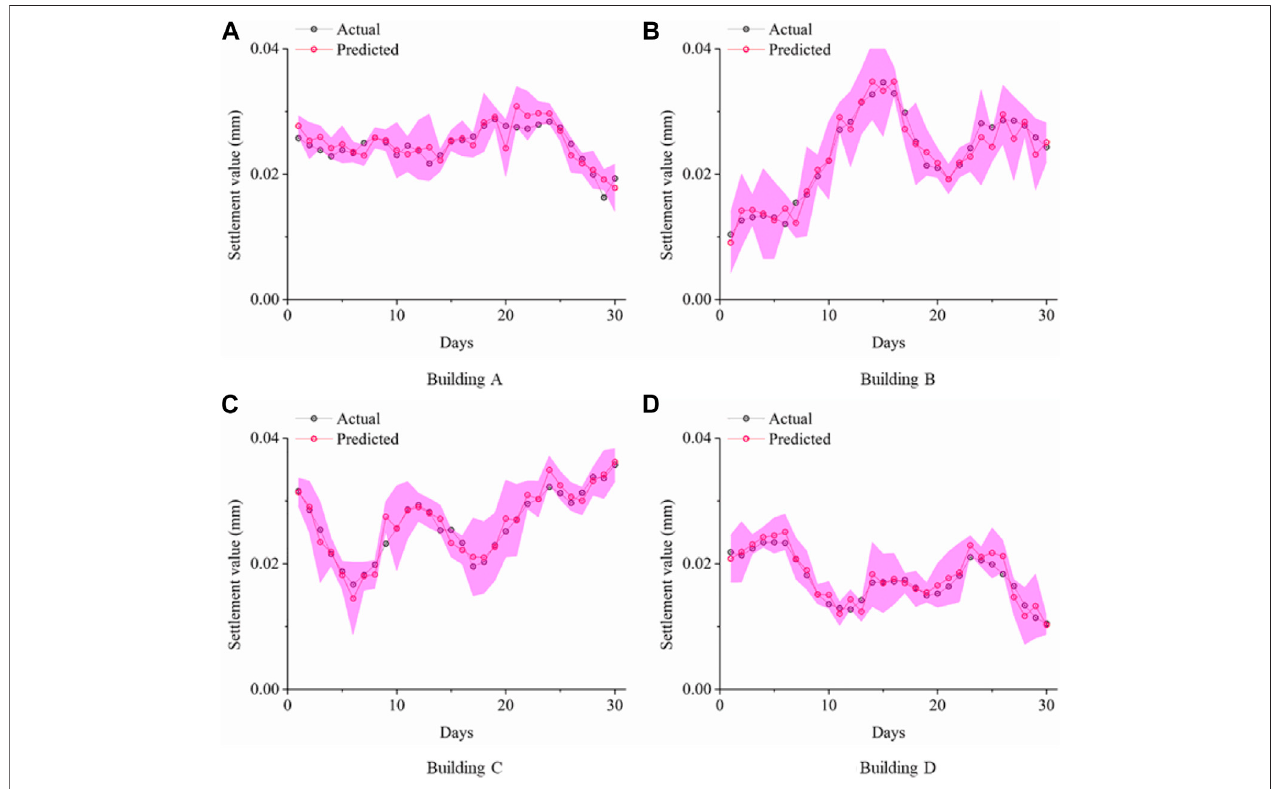
FIGURE 10 | Prediction intervals constructed for the testing dataset using KELM.